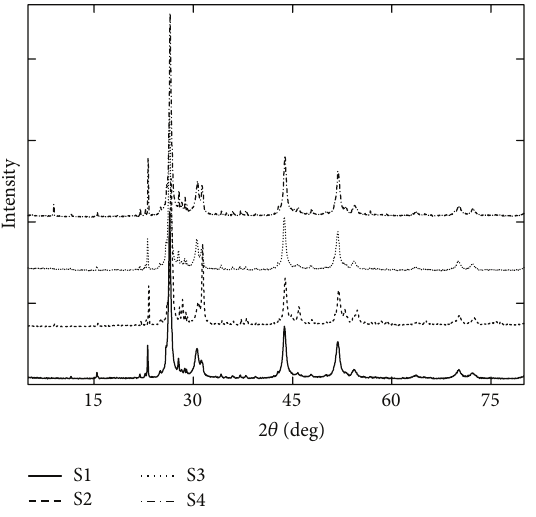
Figure 7: XRD spectra of Zuota